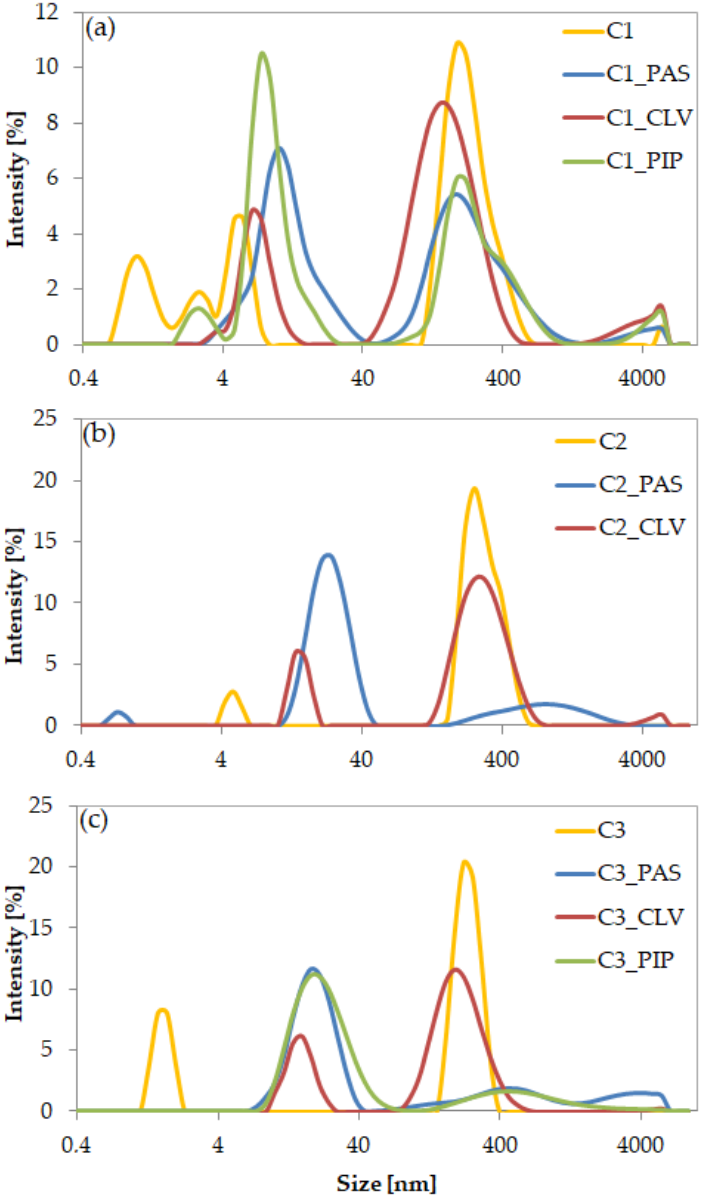
Figure 6. DLS histograms for particles of ( a ) C1, ( b ) C2, and ( c ) C3 systems in deionized water at 25 ° C.